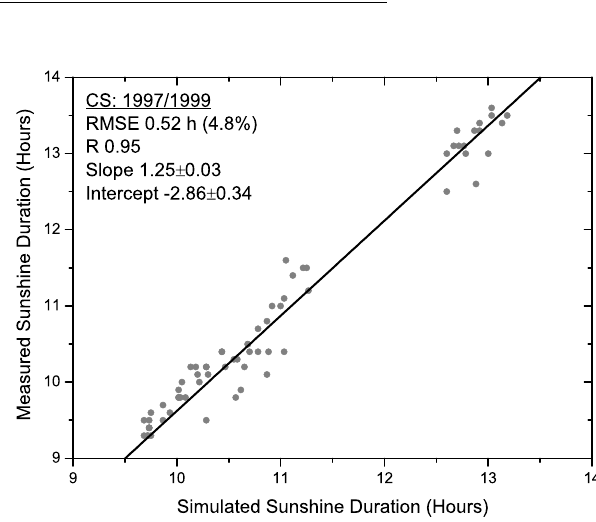
Figure 1. Scatter plot of the measured SD from CS instrument versus SD obtained from LibRadtran model when DSR exceeds a Fig. 1. Scatterplot of the measured SD from CS instrument versus threshold value of 120Wm − 2 . The root mean square error (RMSE), SD obtained from LibRadtran model when DSR exceeds a thresh- and least-square fit parameters are shown in the old value of 120 Wm (cid:0) 2 . The root mean square error (RMSE), and least-square fit parameters are shown in the legend.